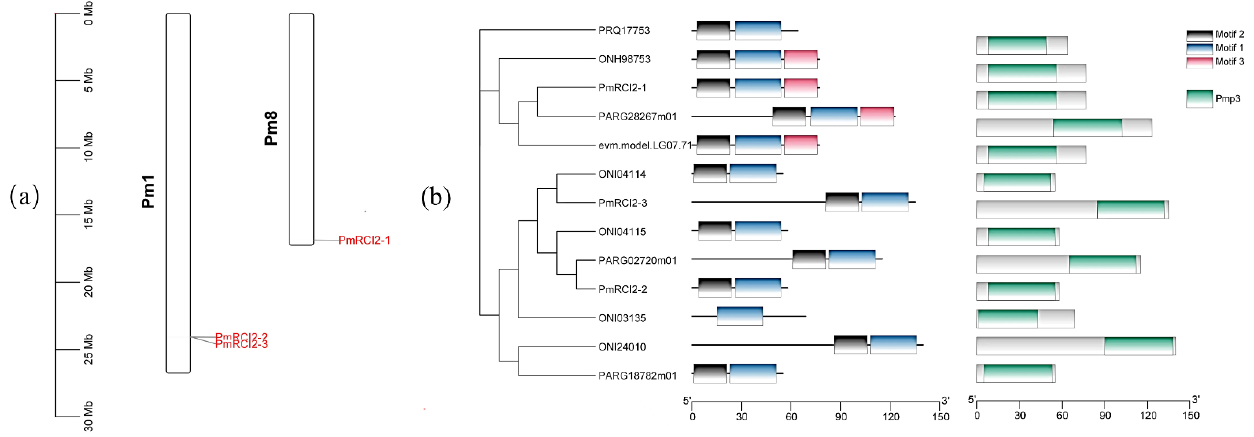
Figure 1. Gene locations and structures of RCI2s in Rosaceae. ( a ) Gene locations of PmRCI2s on the P. mume chromosome. ( b ) The motif composition and conserved domains were identified in RCI2s of P. mume , P. armeniaca , P. salicina , and P. persica .